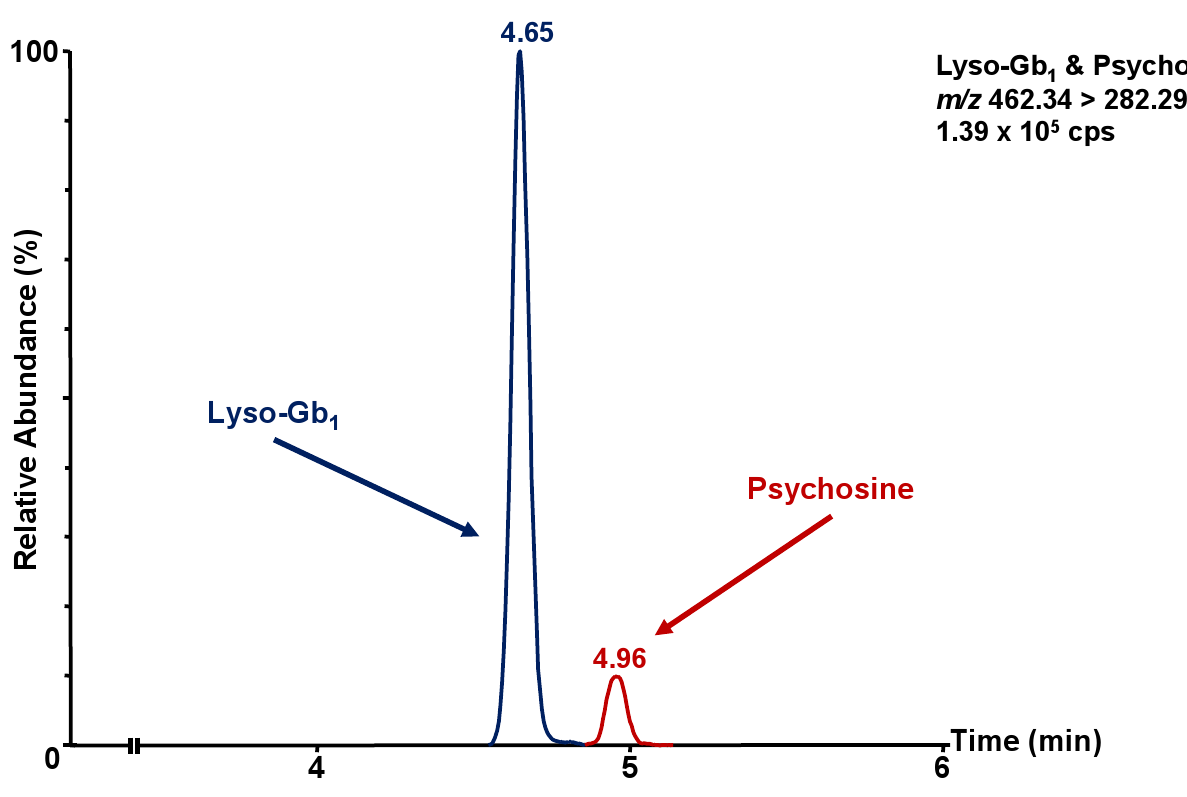
Figure 2. Ion chromatogram obtained by multiple reaction monitoring (MRM) of 60 ng on-column of lyso-Gb 1 standard (blue, retention time: 4.65 min) and 10 ng on-column of psychosine standard (red, retention time: 4.96